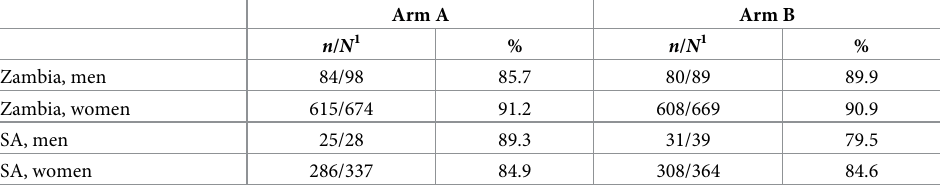
Table 5. Viral suppression among HIV-positive individuals who self-reported they had taken ART in the previous 1 month, from the 24-month follow-up (mid-2016 to mid-2017) of the population cohort